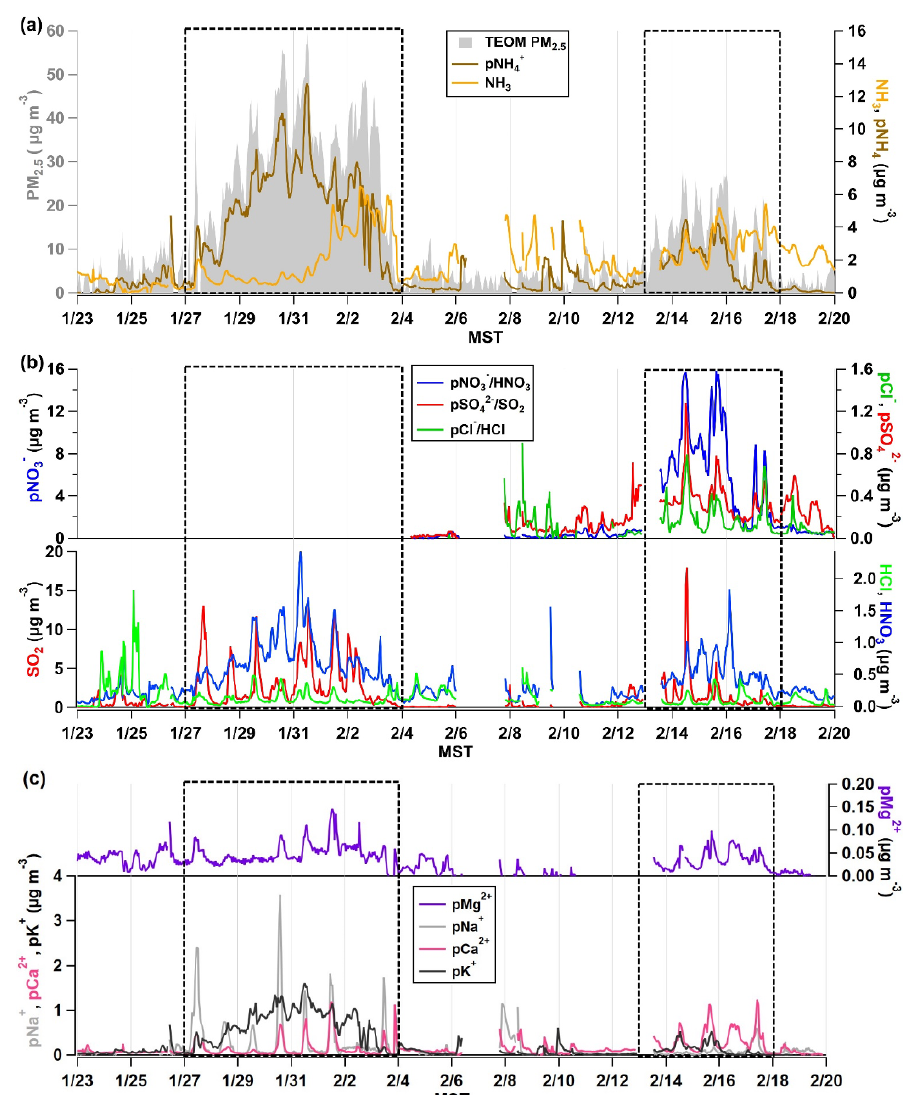
Figure 2. (a) The time series of NH 3 and p NH + observed by the AIM-IC and total PM 2 . 5 mass loading (µgm − 3 ) measured by the TEOM 4 from 23 January to 19 February 2017. (b) The AIM-IC observations of inorganic gases HCl, HNO 3 , and SO 2 and PM 2 . 5 components p Cl − , p NO − , p NO − , and p SO 2 − present in PM 2 . 5 . (c) The AIM-IC observations of the non-volatile inorganic cations p Na + , p K + , p Mg 2 + , and 2 3 4 p Ca 2 + measured in PM 2 . 5 for the entire campaign period. The two PCAP pollution episodes captured during the campaign are emphasized by the dotted black line. Time is expressed in mountain standard time